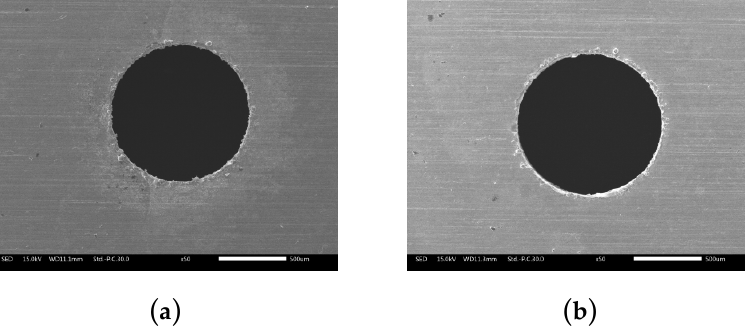
Figure 15. Orifice morphologies of holes processed with different tube electrodes: ( a ) Cylindrical tube electrode; ( b ) helical tube electrode.